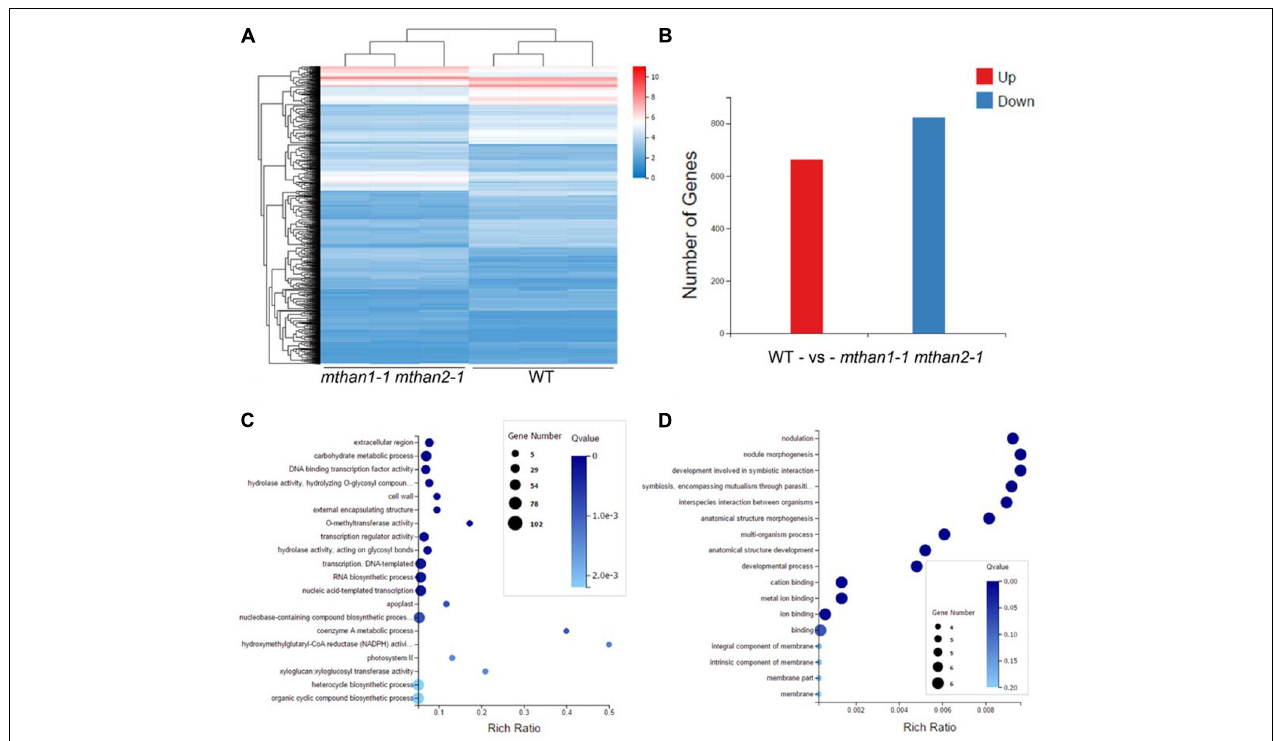
FIGURE 6 | Different expression genes (DEGs) in mthan1-1 mthan2-1 nodules and gene ontology (GO) enrichment of DEGs. (A) The heatmap of fragments per kilobase of transcript per million reads mapped (FPKM) values of 1,485 differential expressed genes in three biological replicates of nodules from WT and mthan1-1 mthan2-1 plants. (B) The number of up-regulated and down-regulated genes in the mthan1-1 mthan2-1 nodules at 21 dpi. (C) The top 20 significantly enriched GO term of DEGs. (D) GO enrichment associated to nodulation and